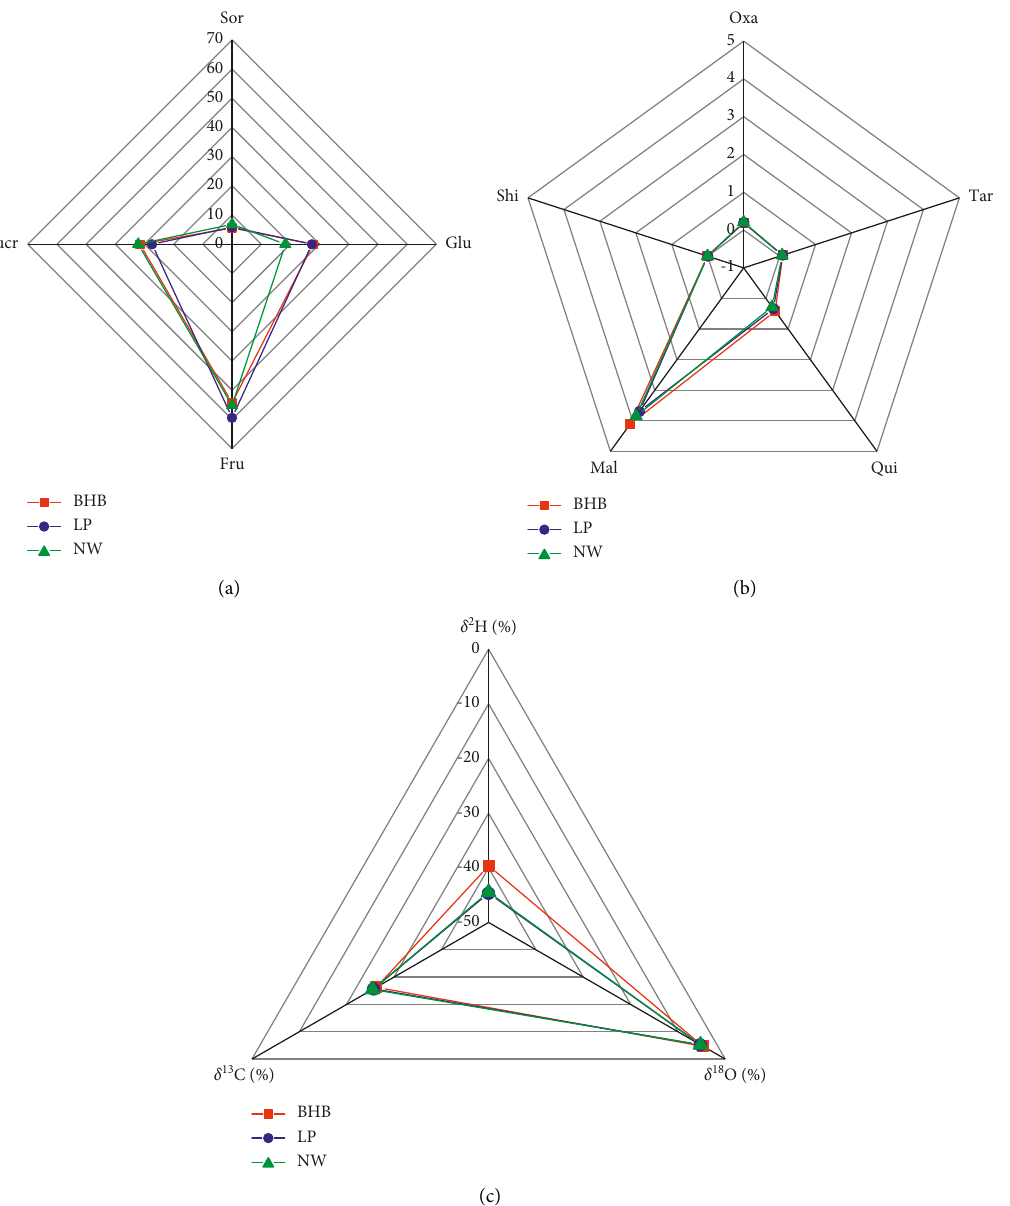
Figure 2: The content characteristics of soluble sugars (a), organic acids (b), and stable isotopes (c) in samples from different